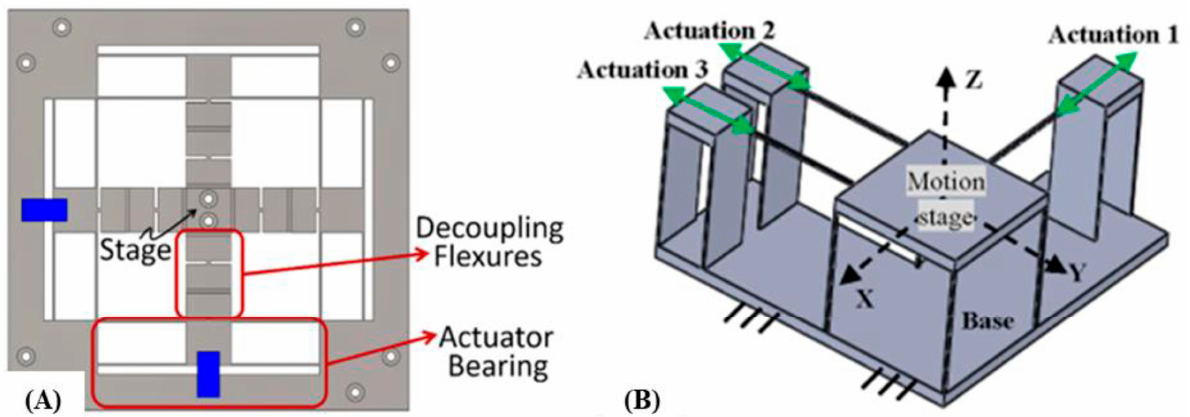
Figure 15. Actuator isolation. ( A )Isolation direction is firstly identified with FACT, and actuator decoupling flexures designed accordingly [118]; ( B ) Isolation with wire beams